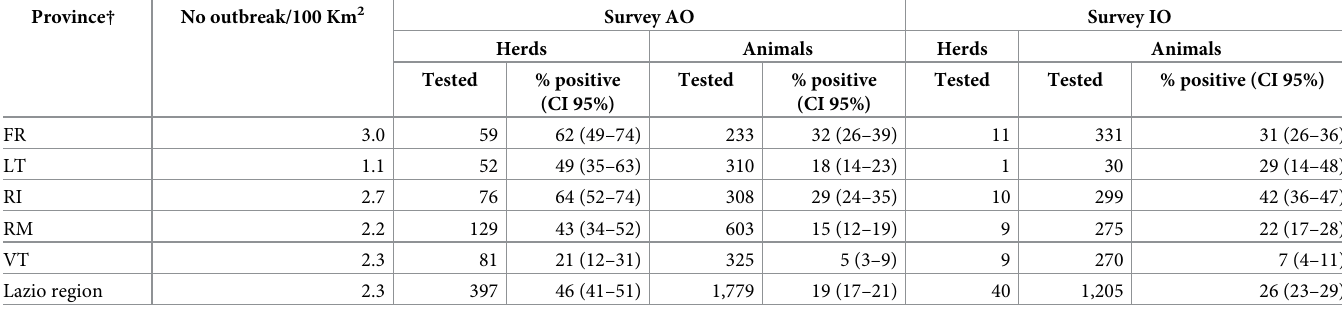
Table 2. The seroprevalence of bluetongue in the sheep population.